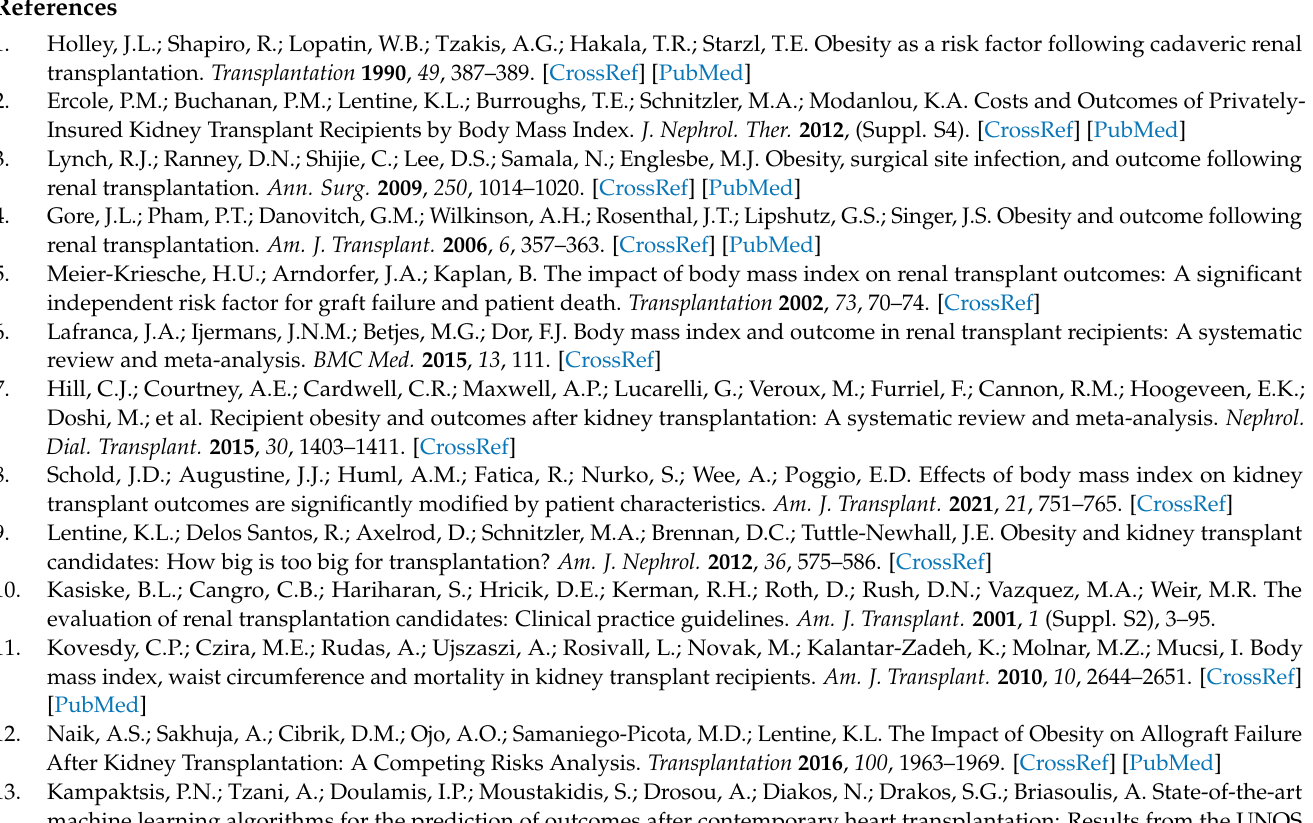
white to blue color scale of each cluster. Figure S10: A. Proportion of clusters according to the regions. B. OPTN regions. Figure S11: 1-year rejection